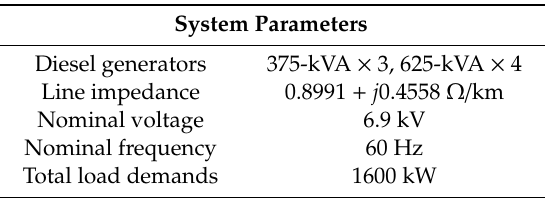
Table 1. Parameters of “D”